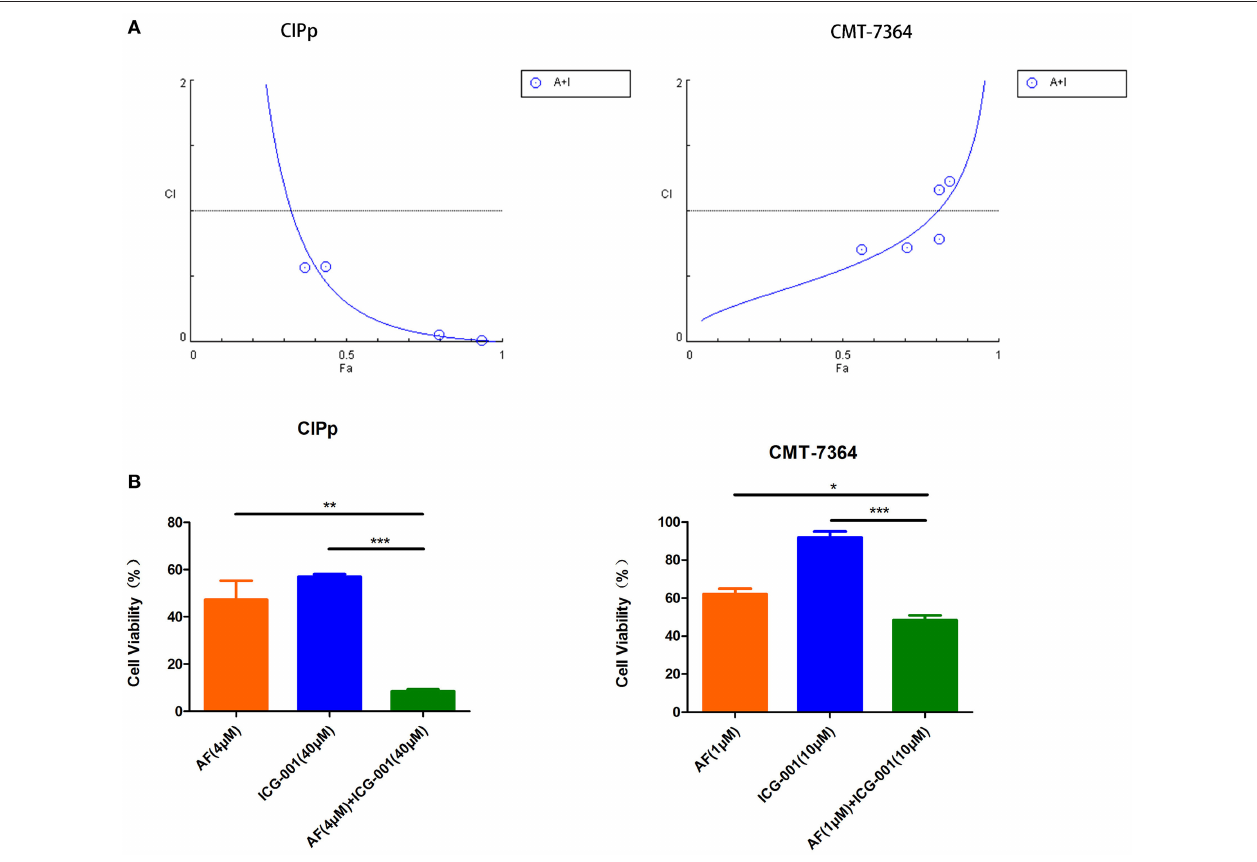
FIGURE 1 | Combination of AF and ICG-001 Synergistically Suppresses Cell Viability of CBC. (A) The combination index (CI) of the combination of AF and ICG-001 of CIPp and CMT-7364 cell lines. Fa, fraction affected. (B) The cell viability of CIPp and CMT-7364 cell lines after drug treatment. Data were representative of three independent experiments. p -values: * p < 0.05; ** p < 0.01; *** p <